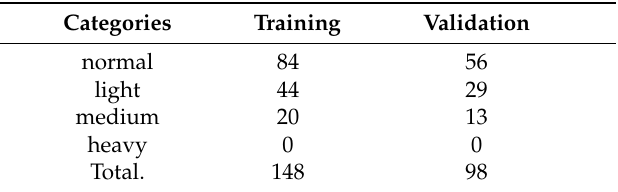
Table 3. Training and validation samples.